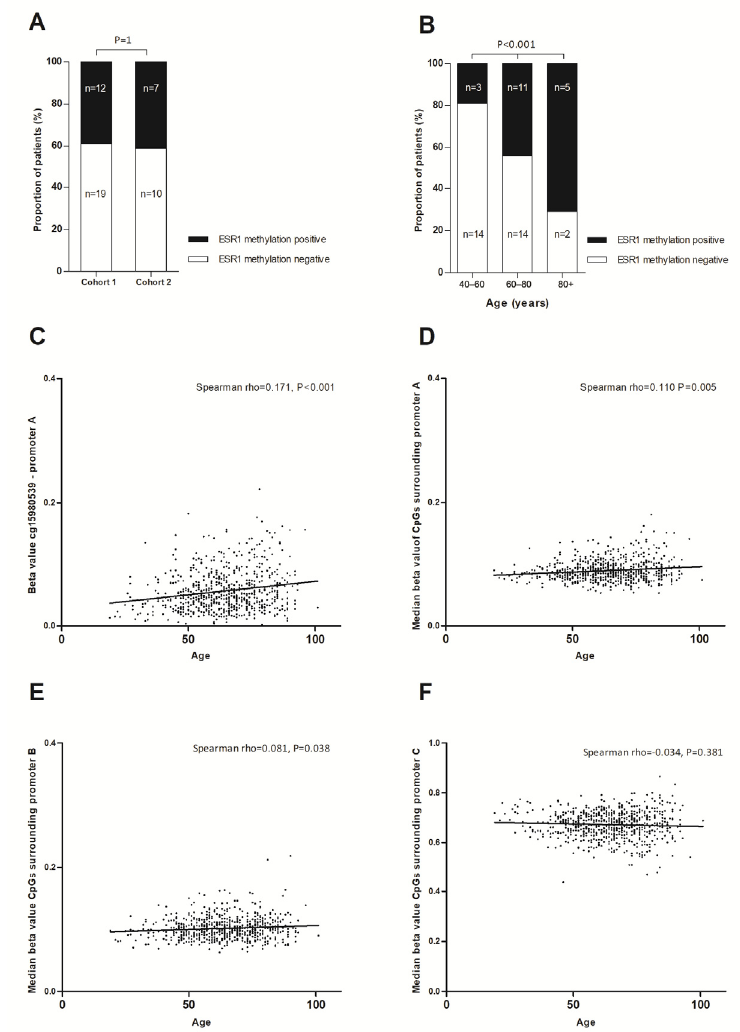
Figure 3. ( A , B ). ESR1 methylation in cfDNA from patients from cohorts A and B. ( A ). Prevalence of ESR1 methylation in cfDNA is not increased in endocrine-resistant patients; Fisher’s exact test ( B ). Prevalence of ESR1 methylation in cfDNA increased with age; chi-square test for trend ( C – F ). ESR1 methylation in cfDNA from healthy subjects, and association with age. Data were publicly available and downloaded from Hannum et al. Mol Cell 2013. ( C ). Beta value of cg15980539, targeted by our ESR1 methylation assay ( D ). Median beta value of CpG dinucleotides located at promoter A ( E ). Median beta value of CpG dinucleotides located at promoter B ( F ). Median beta value of CpG dinucleotides located at promoter